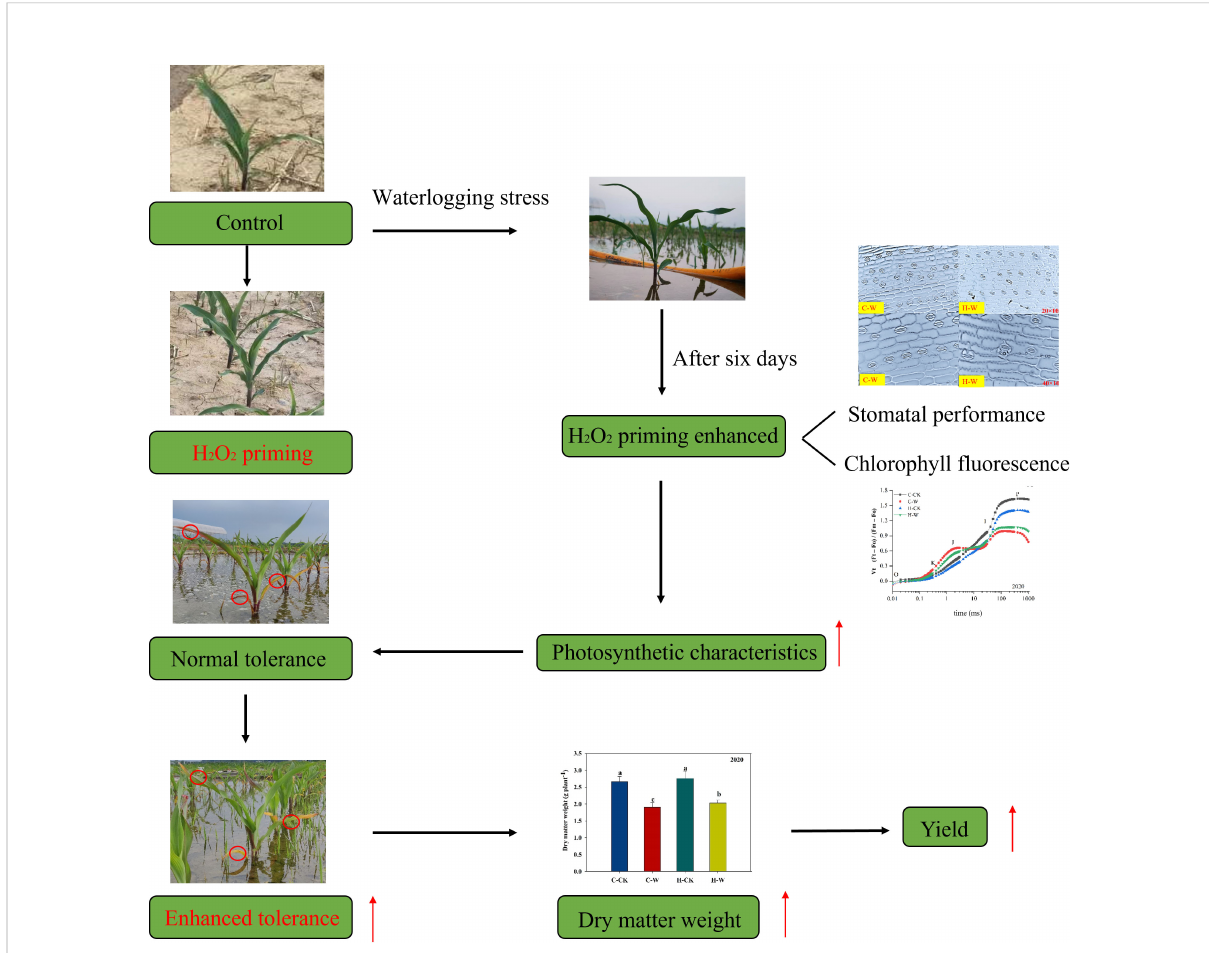
FIGURE 9 The mechanism of H 2 O 2 priming could enhance the photosynthetic characteristics of summer maize. Note: Red circles indicated H 2 O 2 priming versus fl ooded maize leaves, and red arrows indicated that H 2 O 2 priming alleviates fl ooding